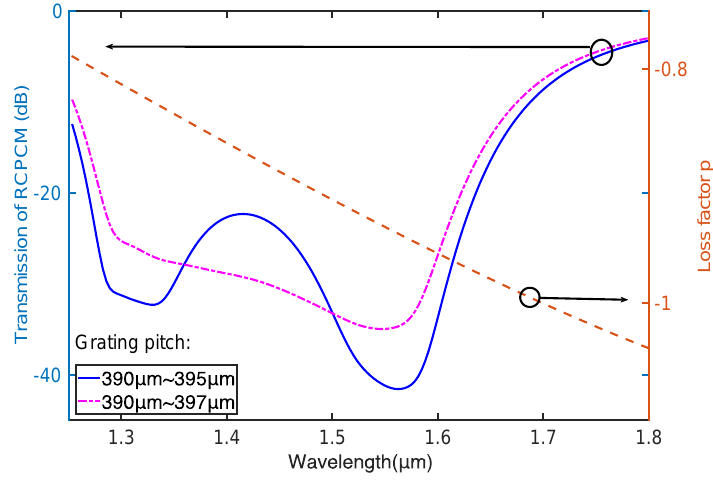
Figure 8. Transmission of RCPCM and corresponding loss factor in coated chirped CLPG.